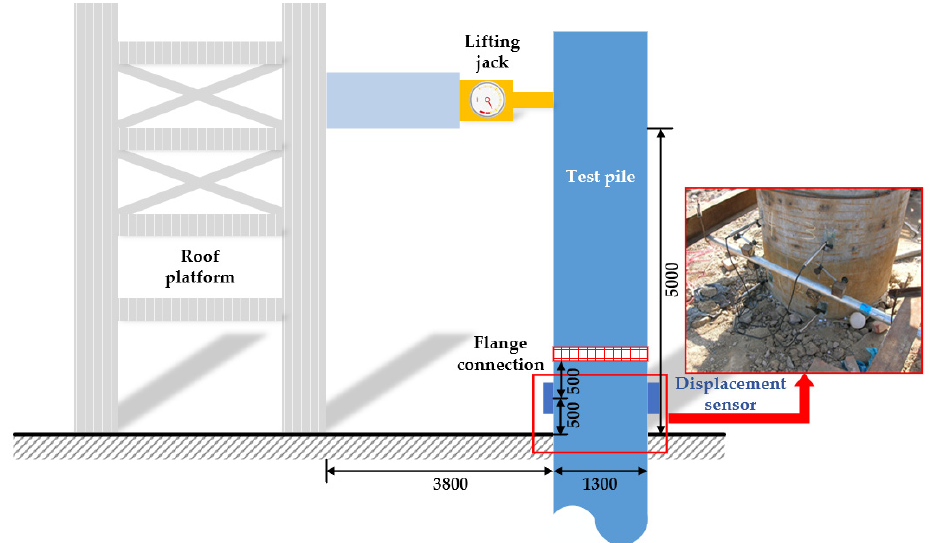
Figure 5. Construction of ballast platform for a horizontal static load test (unit: mm).